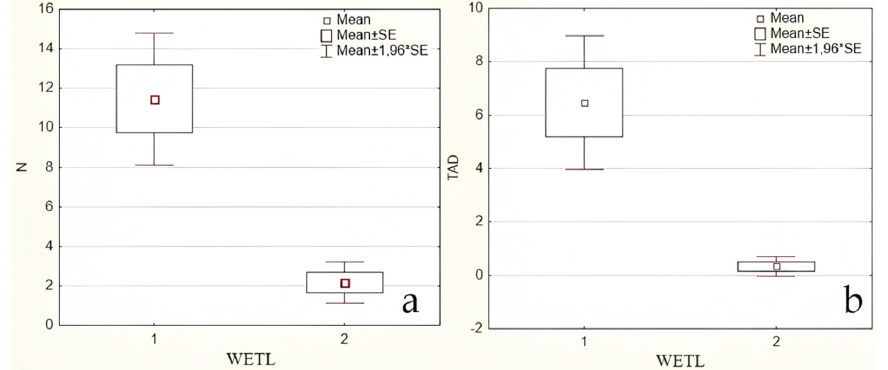
Figure 5. The number of amphibian individuals counted in Silene Nature Park, South East of Latvia, in 2022 using method 2.2.3 (the number of amphibian (all) - “N”, mean/pond, ( a )), and the number of amphibian larvae (“TAD”, mean/pond, ( b )) caught using traps, depending on wetland isolation (“wetl”): 1—geographically isolated wetlands (GIW); 2—non-isolated ponds (nGIW).